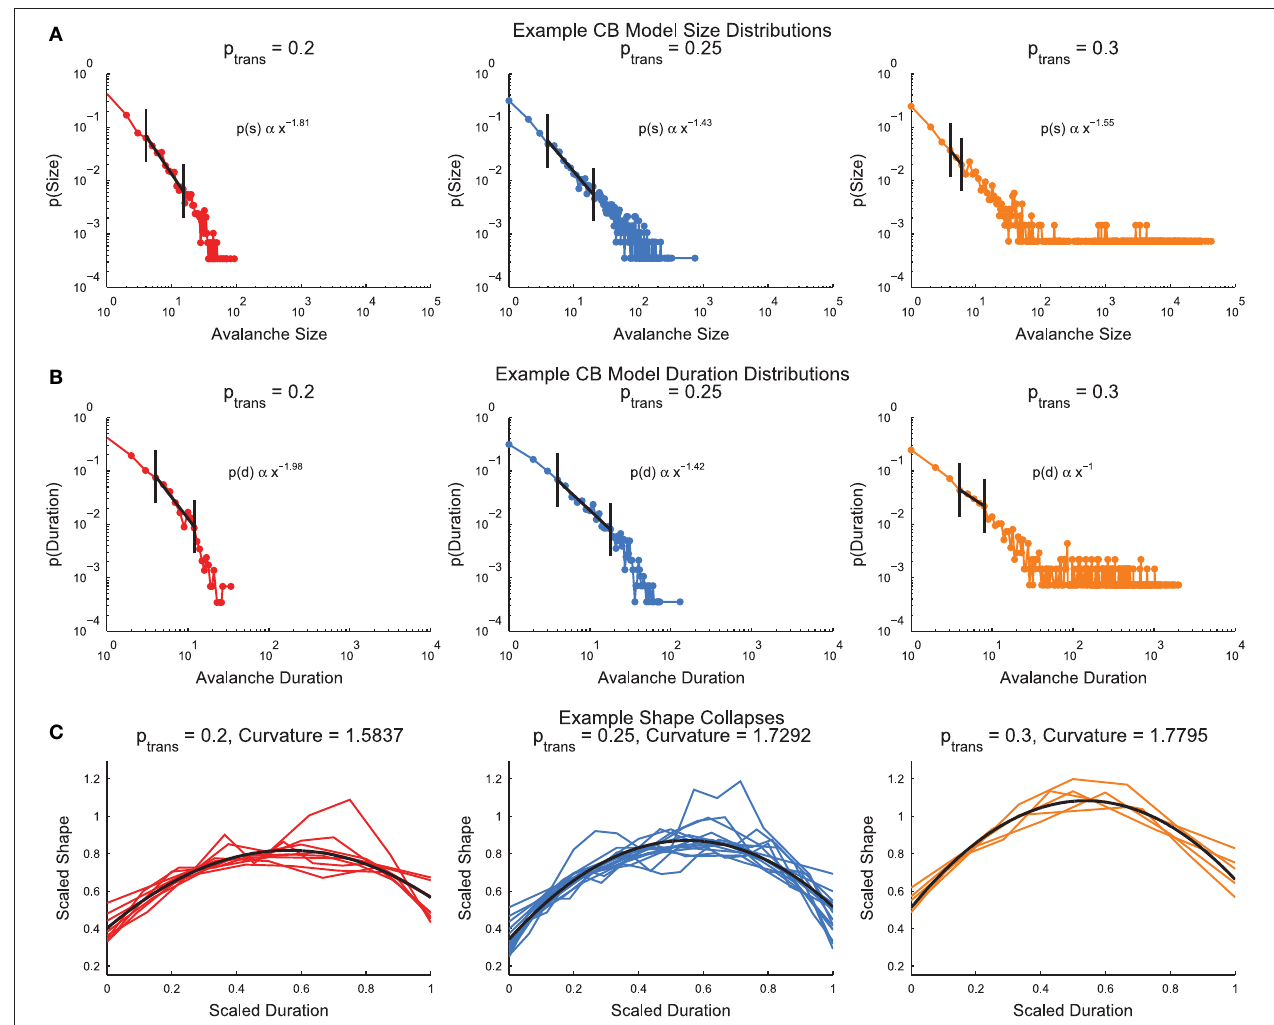
FIGURE 6 | Example cortical branching model distributions and shape collapse. (A) Size distributions for three example models with low (left), near critical (center), and high (right) transmission probabilities. (B) Duration distributions for three example models with low (left), near critical (center), and high (right) transmission probabilities. In (A,B) , note that the low transmission probability distributions curve downwards, while the high transmission probability distributions curve upwards. This behavior is indicative of sub-critical and super-critical systems. Automatically detected truncated fit regions marked in black (see Section 2.7) (C) Example shape collapses. Note that all three transmission probabilities qualitatively appear to exhibit shape collapse. Quadratic fit of shape collapse shown in black (see Section 2.8).